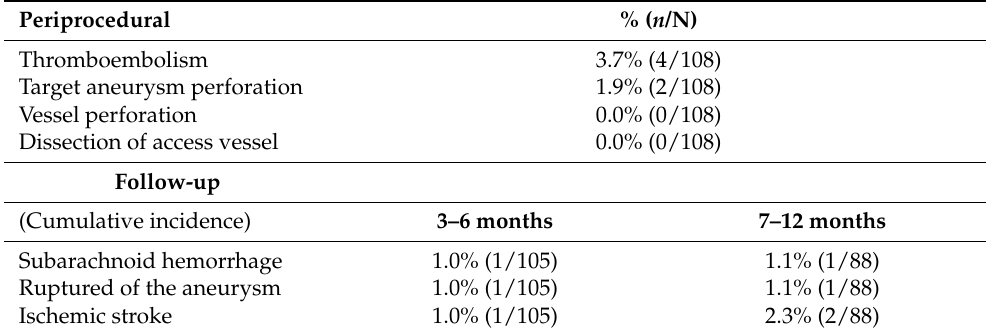
Table 4. Secondary safety endpoint analysis (PP